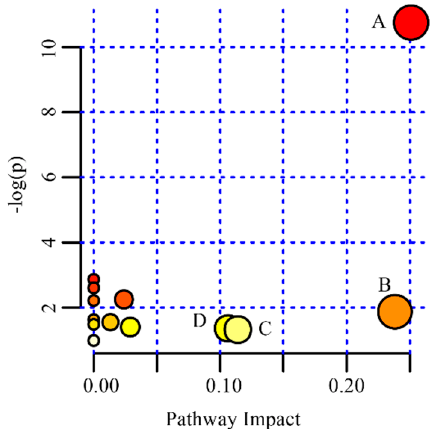
Figure 7. Summary of pathway analysis with MetPA. ( A ) glycerophospholipid metabolism; ( B ) nicotinate and nicotinamide metabolism; ( C ) alanine, aspartate and glutamate metabolism; ( D ) pyruvate metabolism.